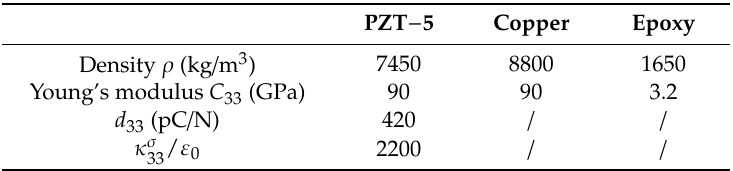
Table 2. The material parameters of